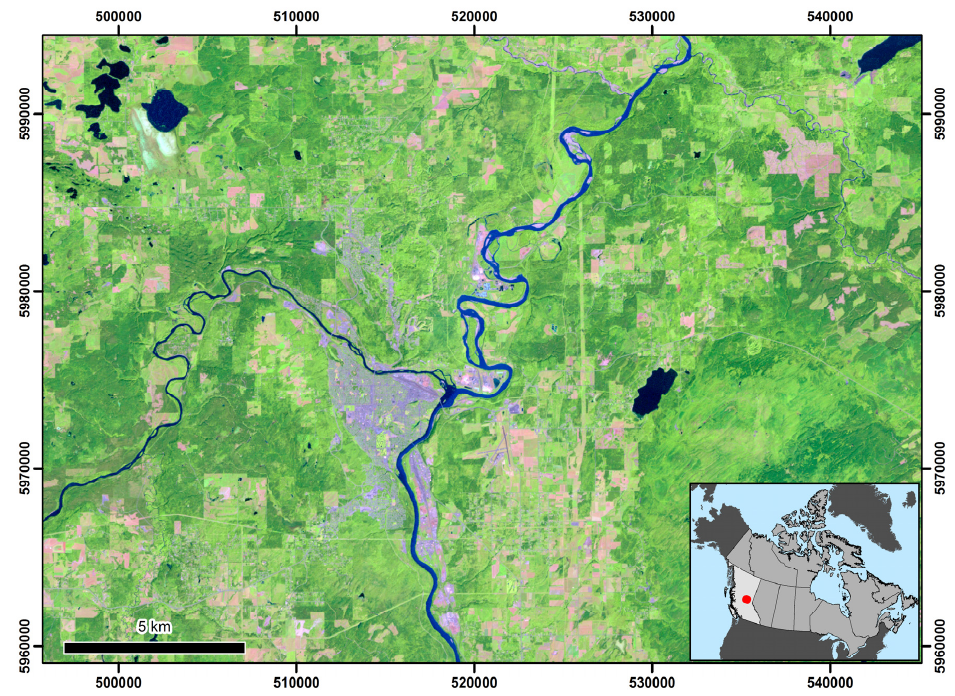
Figure 1. Location of the study area near Prince George, British Columbia, Canada overlaid on the C2C (Composite2Change) proxy composite image for 2003.